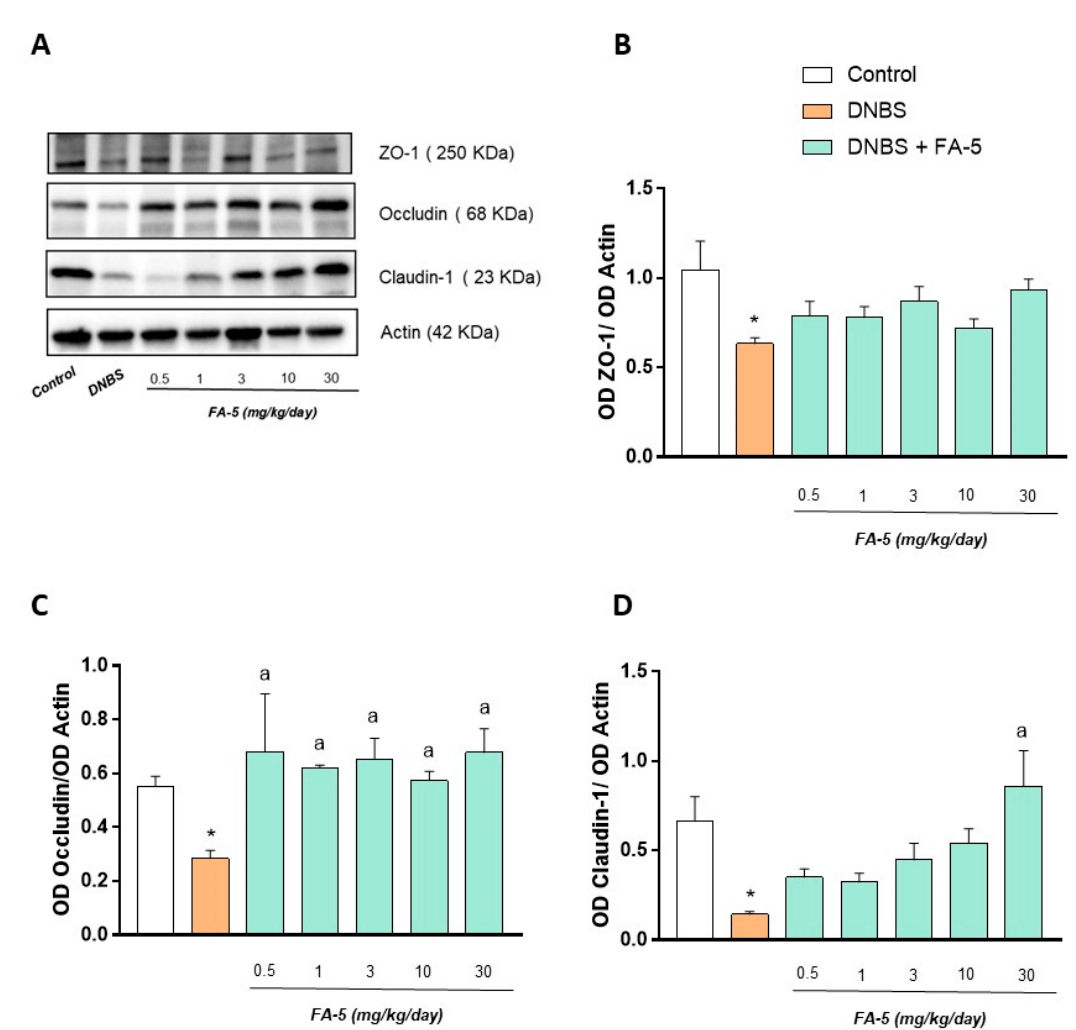
Figure 6. Representative blots ( A ) and densitometric analysis of the expression of ZO-1 ( B ), occludin ( C ), and claudin-1 ( D ) in colonic tissues from control rats and animals treated with DNBS alone or in combination with FA-5 (0.5, 1, 3, 10, 30 mg/kg/day). Each column represents the mean ± standard error of the mean (SEM) ( n = 6). One-way ANOVA followed by Tukey’s post hoc test results: * p < 0.05, significant difference vs. the control group; a p < 0.05, significant difference vs. the DNBS group.